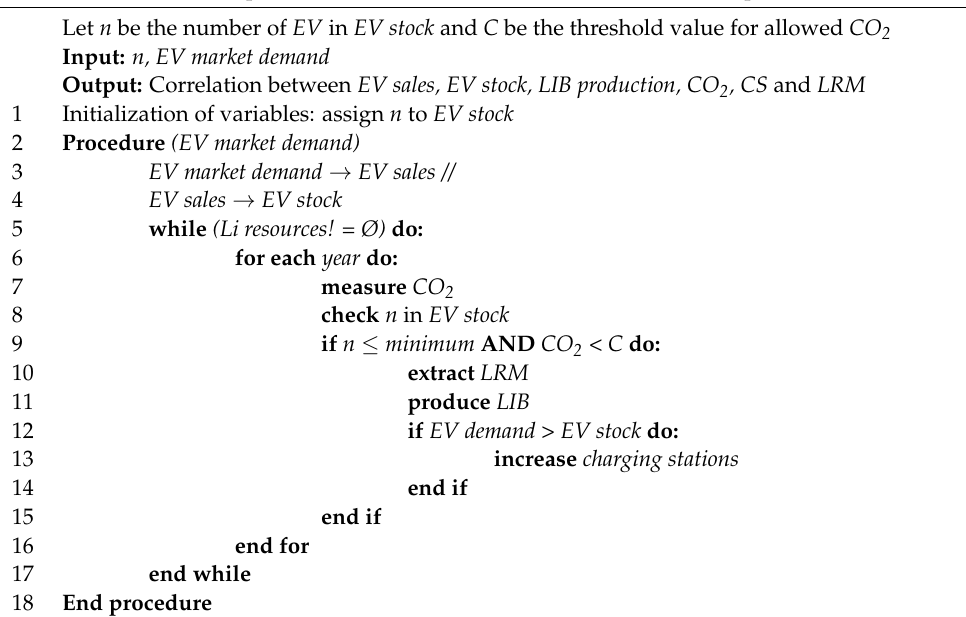
Algorithm 1. Global impact of electric vehicle market demand on lithium